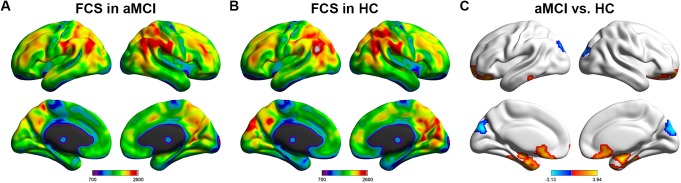
The FCS in aMCI and HCs and the group differences.(A) and (B) These two pictures showed the mean FCS both in aMCI and HCs. The color bar represents the FCS value for each group and the warm color means higher FCS value. (C) This picture indicated the group differences between aMCI patients and HCs on FCS value. The color bar at the bottom represents T value (p < 0.05, Cluster > 309 voxels). FCS, functional connectivity strength; aMCI, amnestic mild cognitive impairments; HC, healthy controls.